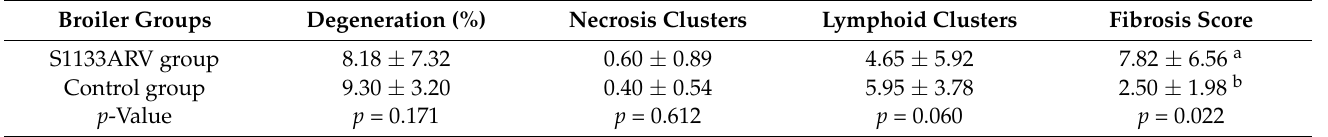
Table 6. Pancreatic histological evaluation of broiler chickens vaccinated with the avian reovirus S1133 strain. Broiler